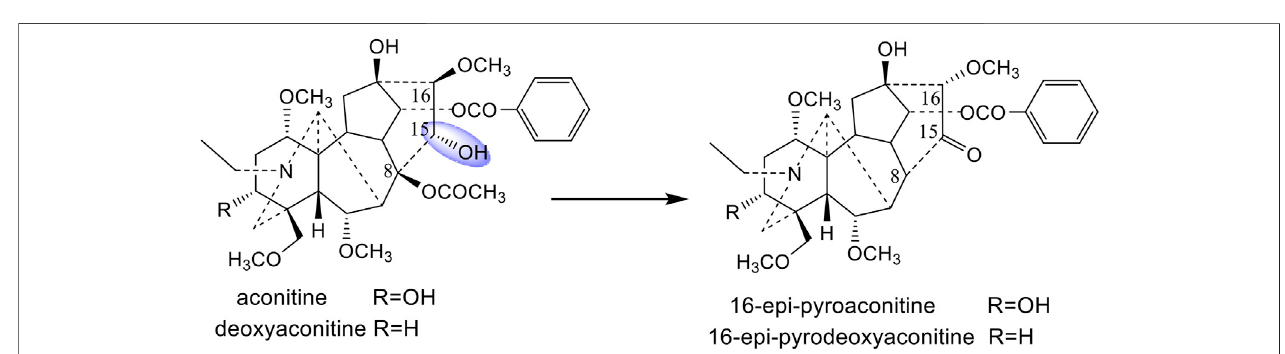
FIGURE 8 | Prototype compounds and the corresponding sand-fried products (Wang et al., 2010b; Wang et al., 2011).